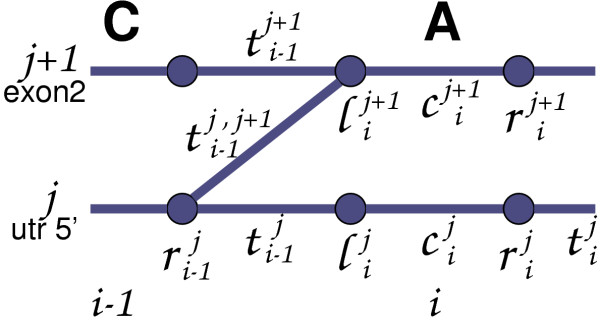
Detail of EuGène's directed acyclic graph and algorithm. The zoomed region contains the two first nucleotides of the example sequence of Figure 3 (C at position i - 1, and A at position i), and two annotation tracks (UTR5' for j and exon in frame 2 for j + 1). The contents edges c connect the l vertices to the following r vertices of the same track. Transition edges t are either horizontal and link the r vertices to the l vertices of the same track, or transversal and link the r vertices to all possible l vertices according to the occurrence of a biological signal in the sequence. In this example, between  and  a vertex  allows the transition from the UTR5' track at position i - 1 to the exonic track at i because the A nucleotide at position i is the first nucleotide of a potential start codon ATG. The dynamic programming algorithm used in EuGÈNE determines, for each vertex r, which vertex precedes r in the optimal path. In this example, at position i for the track j the best path leading to  from the left has a weight  (only one origin is possible). For the track j + 1, the best path leading to  will be attributed a weight of either , whatever the lower.